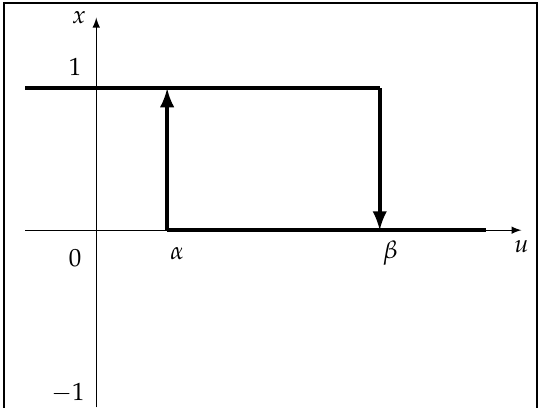
Figure 2. The input-output relation of the converter R [ α , β , x 0 , t 0 ] with thresholds α and β . The hysteresis loop is reverse (i.e., it is directed clockwise) as compared to the classical definition of a non-ideal